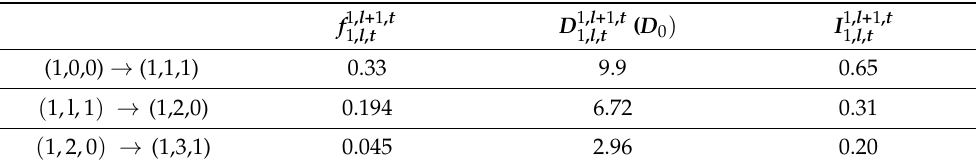
Table 2. The estimated values of oscillator strength f 1, l + 1, t (3) (where D 0 = e ˚A in Debye units) and radiation intensity I 1, l + 1, t electron transitions between the quantum-confined states ( n = 1, l , t ) → ( n = 1, l + 1, t ) (where l = 0, 1, 2 and t = 0, 1) in the QD perovskites { en } FAPbBr 3 with radius a = 5.5